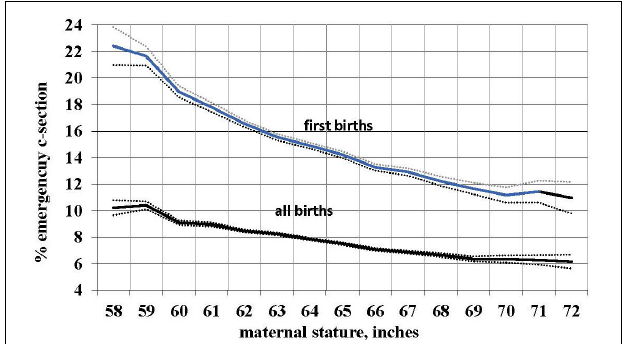
FIGURE 1 | Relationship of mean maternal stature to the risk of an emergency C-section for 3,550,445 total births and 1,122,782 first births with 99% confidence intervals, US, 2013 (without